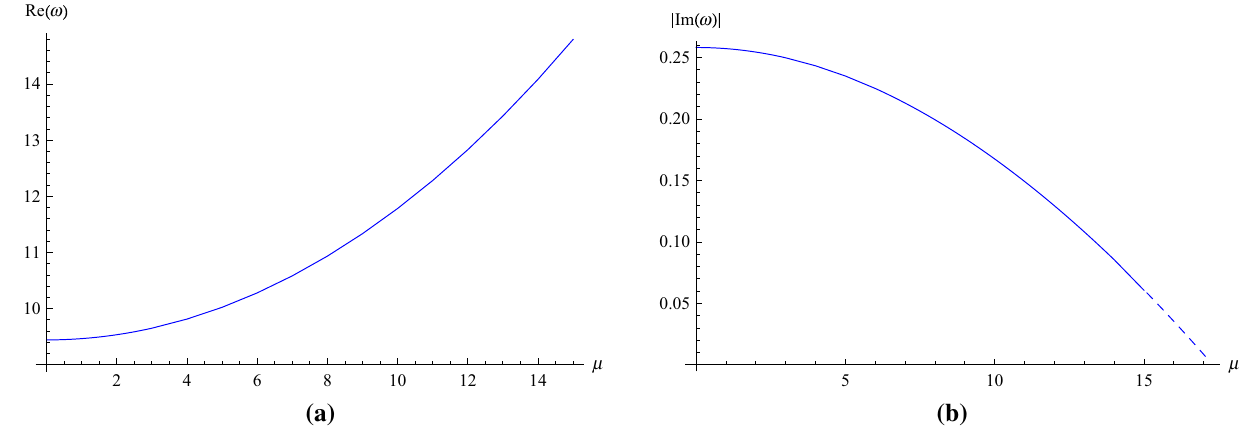
Fig. 3 Dependence of frequency components on mass ω(μ) with s = 0, l = 20, p = 1, μ = 0 ... 16: a Re (ω) ; b absolute value of Im